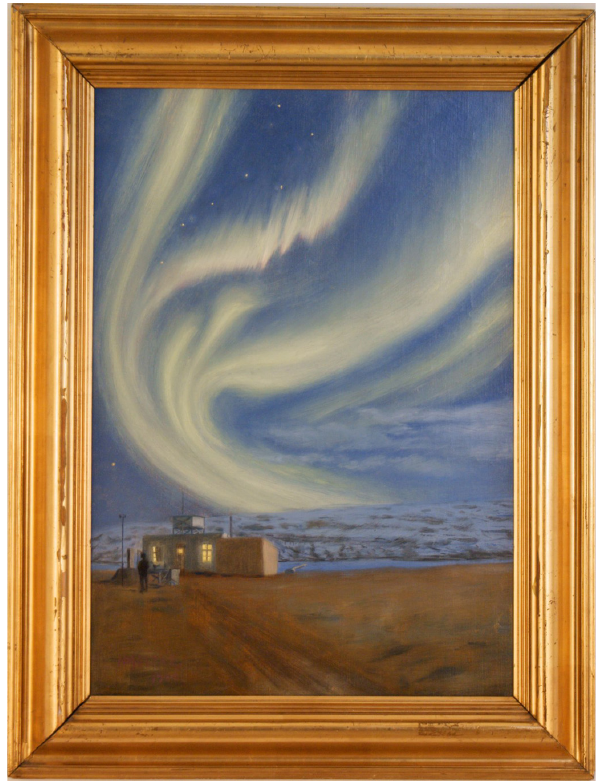
Figure 20. Auroral display observed over the base station “Aurora” in Akureyri on 13 January 1900, at 20:20h by Moltke (Photo,